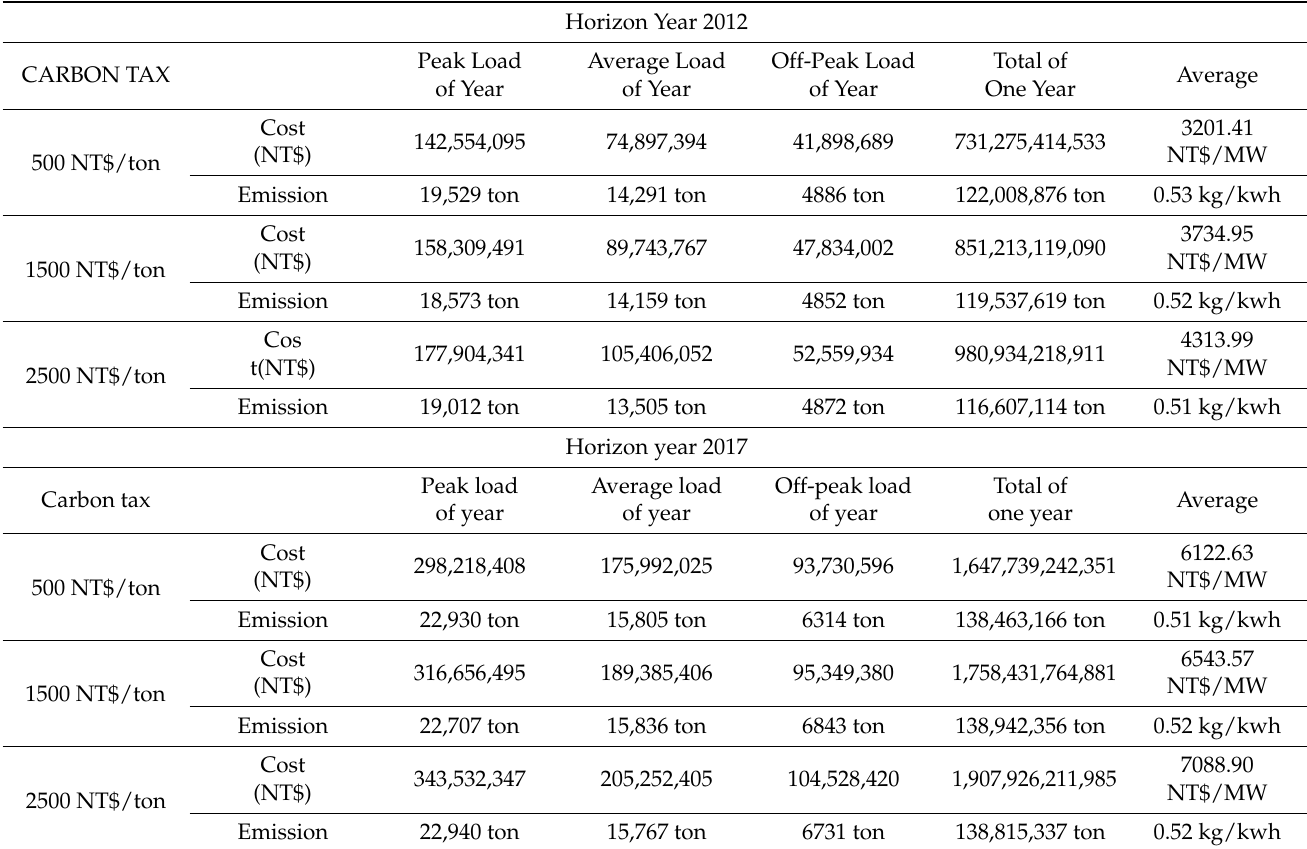
Table 7. The summary of the simulation results of Case